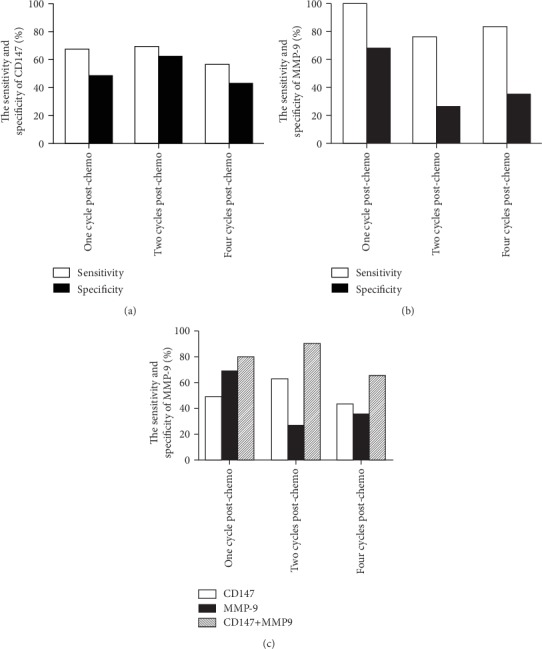
The combination of scCD147 and scMMP-9 as a predictive model for chemotherapy response. (a) The sensitivity and specificity of scCD147 were evaluated after one cycle, two cycles, and four cycles of chemotherapy. (b) The sensitivity and specificity of scMMP-9 were evaluated after one cycle, two cycles, and four cycles of chemotherapy. (c) The specificity of combined scCD147 and scMMP-9 was evaluated after one cycle, two cycles, and four cycles of chemotherapy.